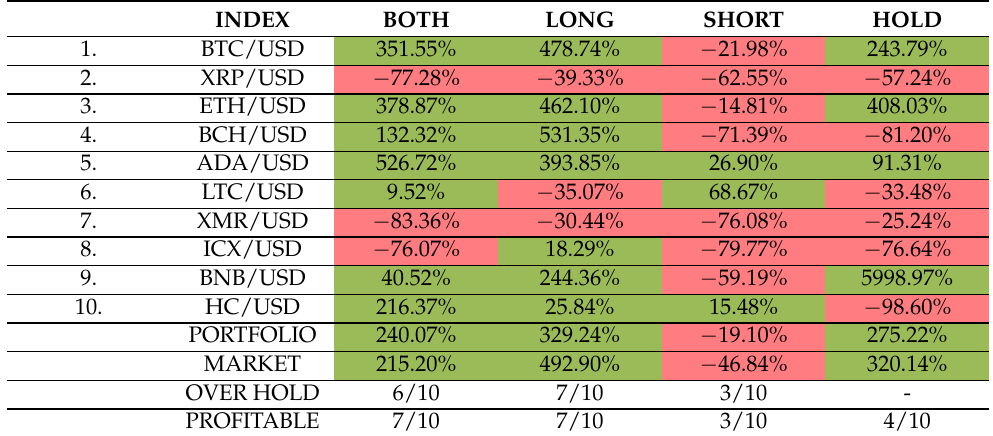
Table 7. The results of the strategy from the third experiment for portfolio and examined cryptocur- rencies. Green indicates positive returns, and red indicates negative returns. In summary, “Over Hold” indicates the number of indexes that achieve above-average